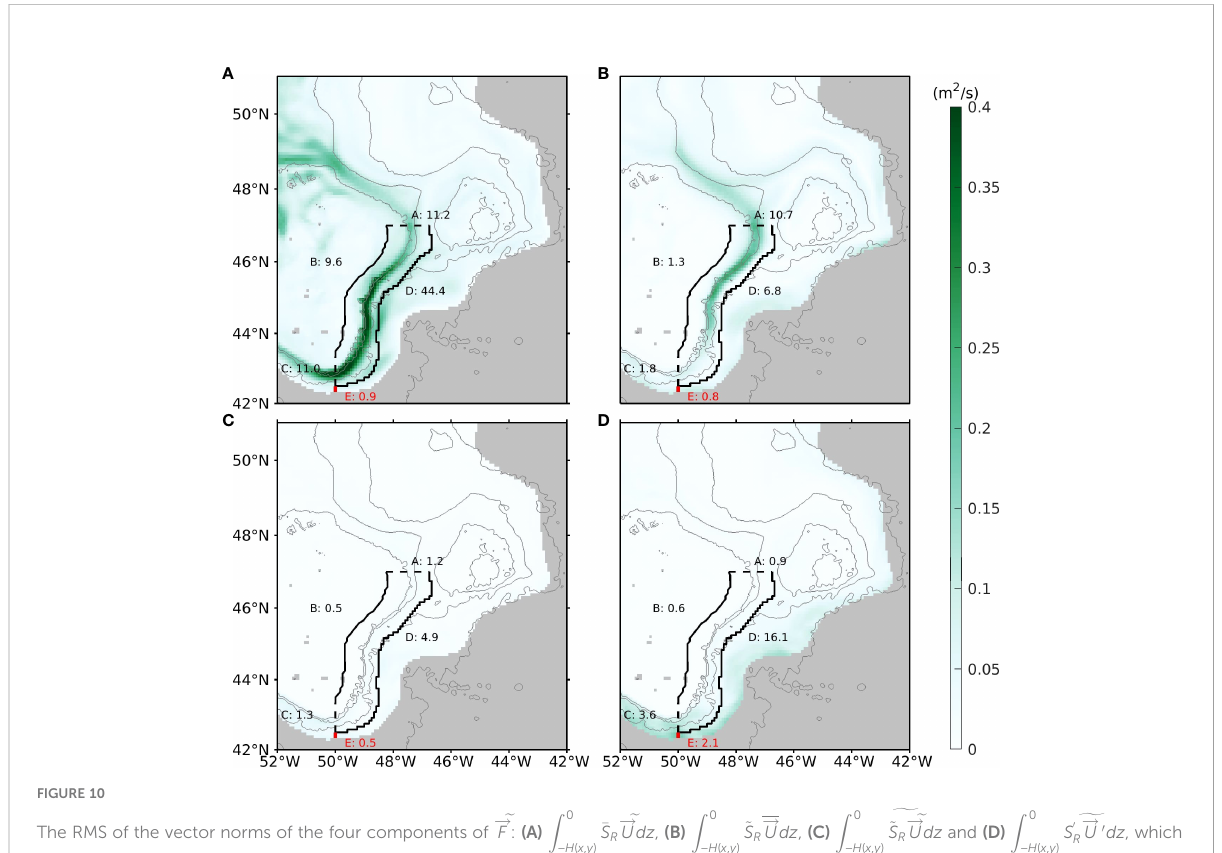
The RMS of the vector norms of the four components of e F are the vertical integrals of the four terms on the right hand side of (6). Numbers having the unit of mSv are the RMS of the four components of the seasonal variation of the FWT across different